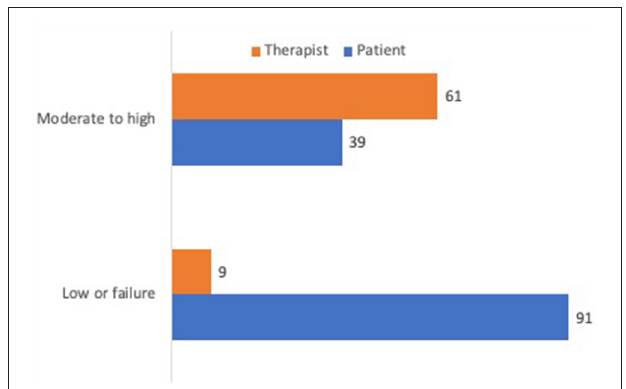
FIGURE 1 | Percentage of RF for patient and